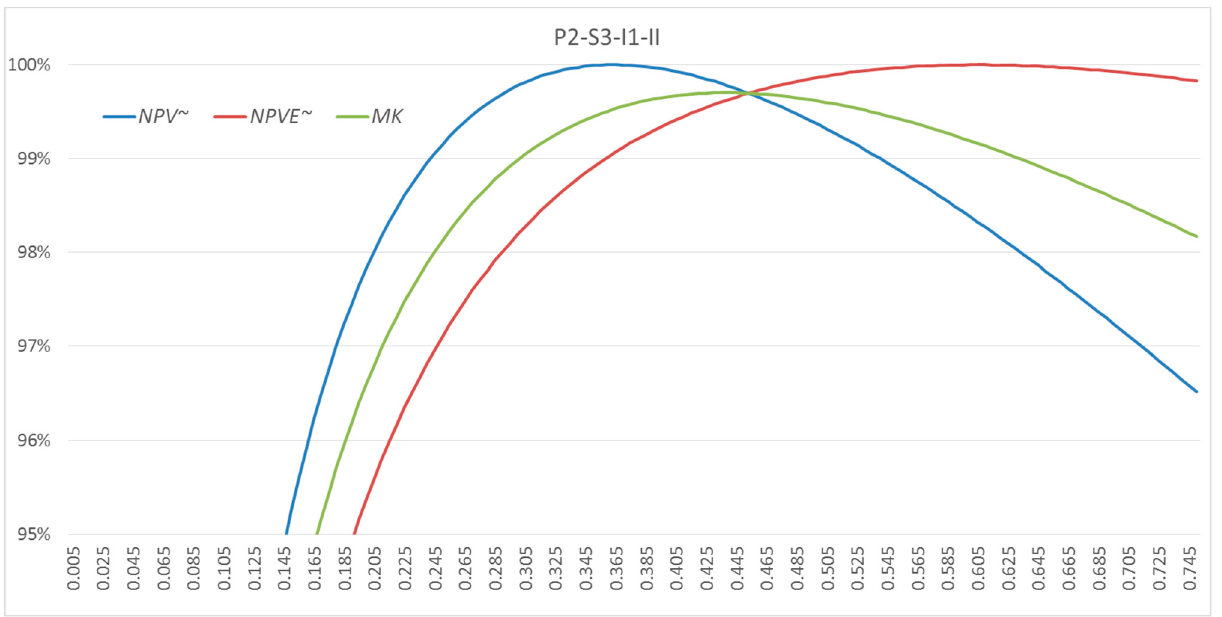
Figure 3. NPV ~ , NPV E ~ and MK values depending on the thickness d for Variant P2-S3-I1-II.